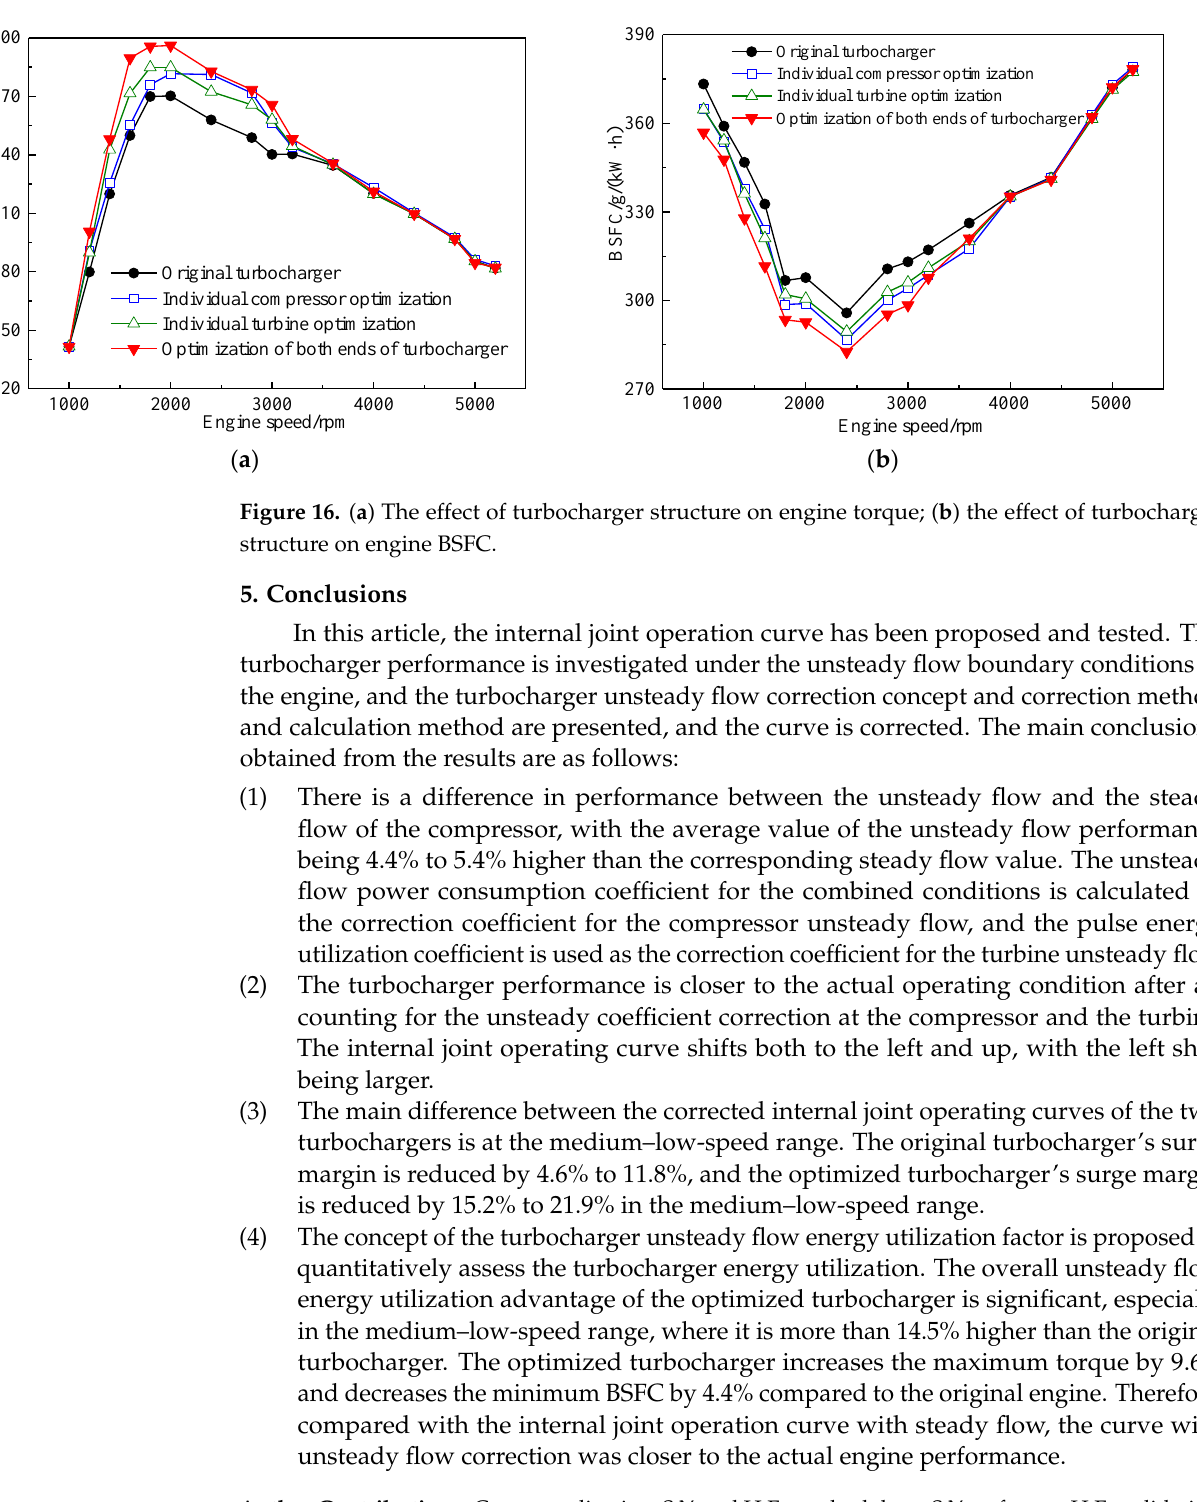
15 of 18 Figure 15. Comparison of turbocharger unsteady flow energy utilization coefficients on internal joint operating curves. The design and performance studies of compressors and turbines are mostly inde- pendent of each other, which is different from the real conditions of turbochargers. The results of optimizing the compressor and turbine separately and optimizing both ends of the turbocharger simultaneously based on the joint operating curves show that optimizing one end of the turbocharger separately results in poorer engine performance than opti- mizing both ends of the turbocharger. The optimized turbocharger increases the maxi-